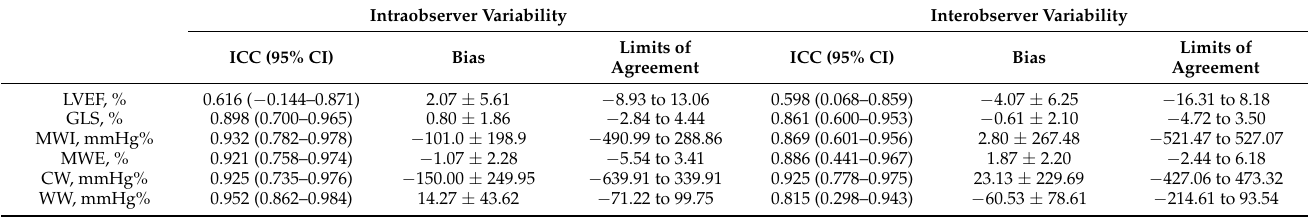
Table A1. Intra- and interobserver